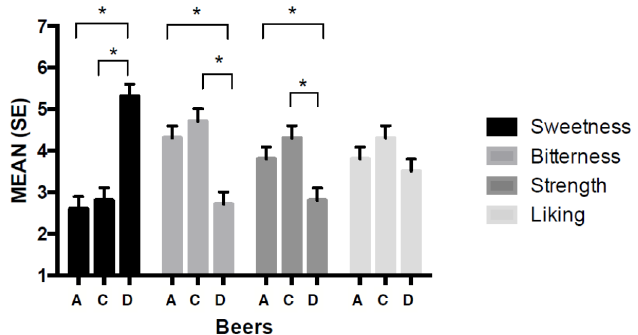
Figure 4. Means and standard error (SE) of sweetness, bitterness, strength, and liking ratings for the three beers in Experiment 2 (asterisks show a significant difference between ratings). Here, it can be seen that all the significant ratings are related to Beer D, the sweetest one. Moreover, most significant differences reported here follow the real differences in these beers’ formulas, expect for the fact that Beer A was rated as stronger than Beer D (Beer A has 4.5% alcohol strength, and Beer D 5.1%).